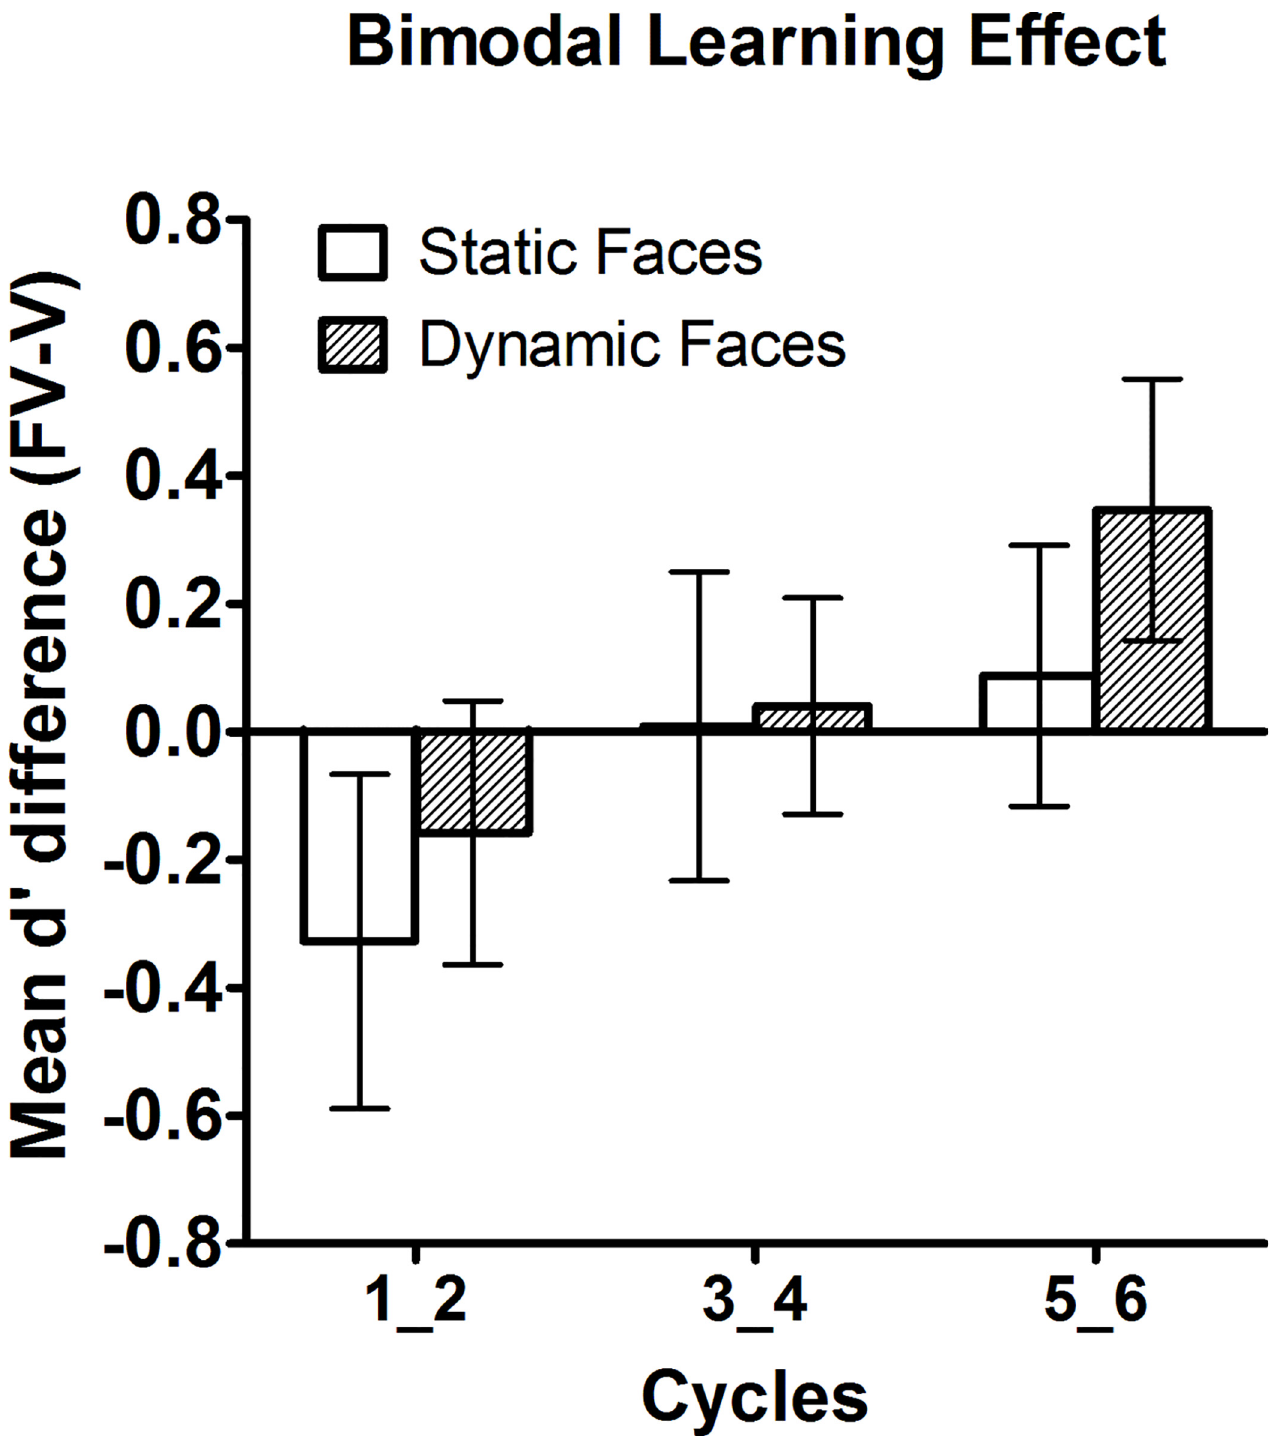
Fig 2. Bimodal learning effect depicted as mean d ’ - differences between face-voice (FV) and voice-only (V) modality conditions for pairs of consecutive study-test cycles in Exp. 1 (static faces) and Exp. 2 (dynamic faces). Note that increasing benefits of bimodal learning from cycle pairs 1_2 towards 5_6 were independent of face animation mode (static vs. dynamic). Error bars are standard errors of the mean (SEM).